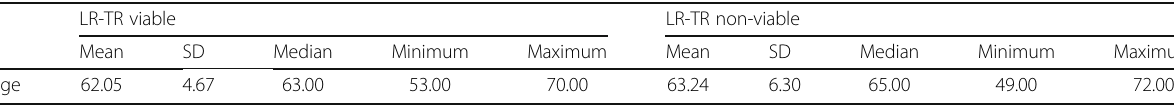
Table 1 The demographic data of 40 treated observations LR-TR viable LR-TR non-viable Mean SD Median Minimum Maximum Mean Median Minimum